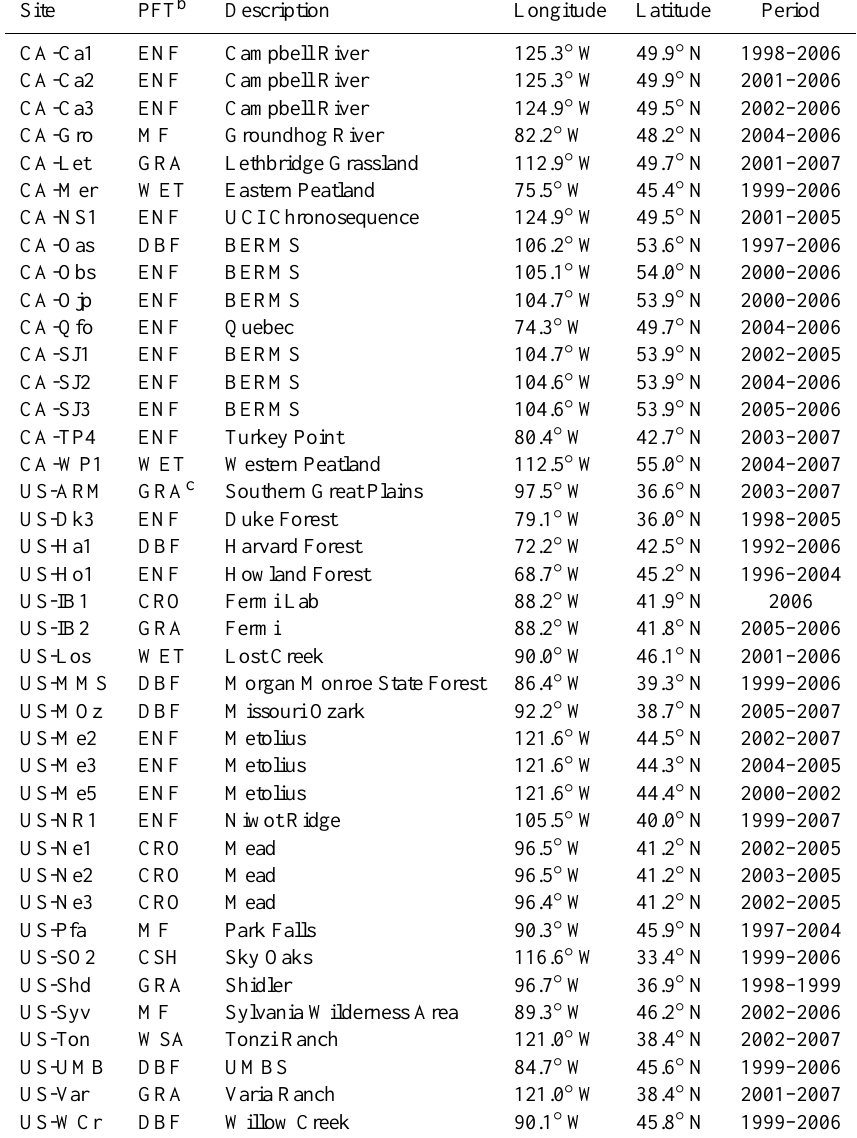
Table A1. Descriptions of NACP sites in Canada (CA-) and US (US-) a